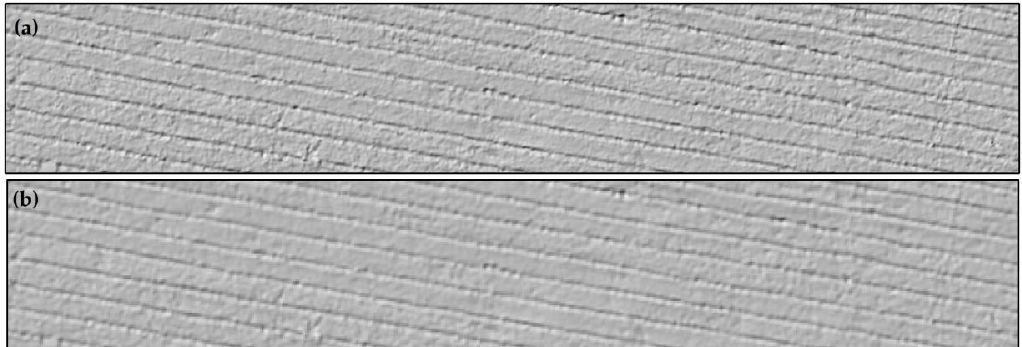
Figure 8. The effect of cubic convolution resampling. (a) IDSM before resampling; (b) the image becomes smoother and background noises were minimized after sampling.